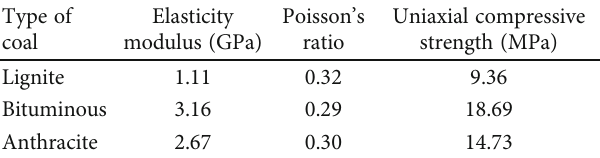
Table 2: Mechanical parameters of dried coal